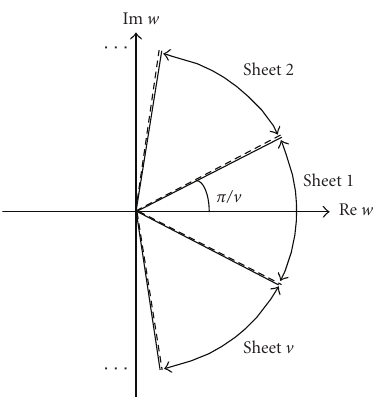
Figure 2: The correspondence between w -plane and s Riemann